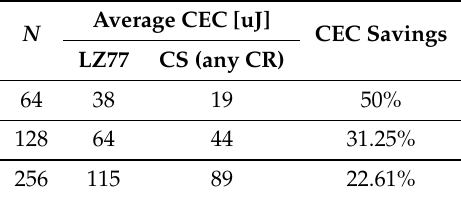
Figure 12. CEC Kruskal–Wallis mean ranks and Dunn comparison intervals for different compression types: ( a ) N = 64; ( b ) N = 128; and ( c ) N = 256. Table 4. Average CEC and CEC savings of CS compared to